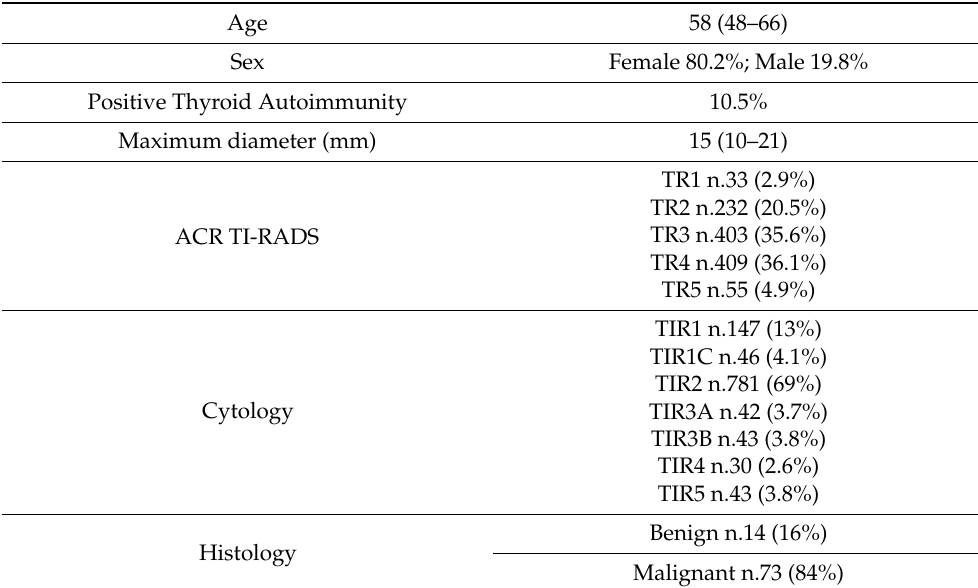
Table 1. Demographic and clinical characteristics of the study.